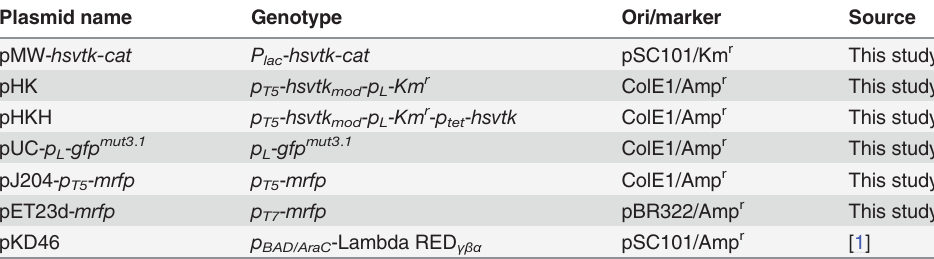
Table 1. Plasmids used in this